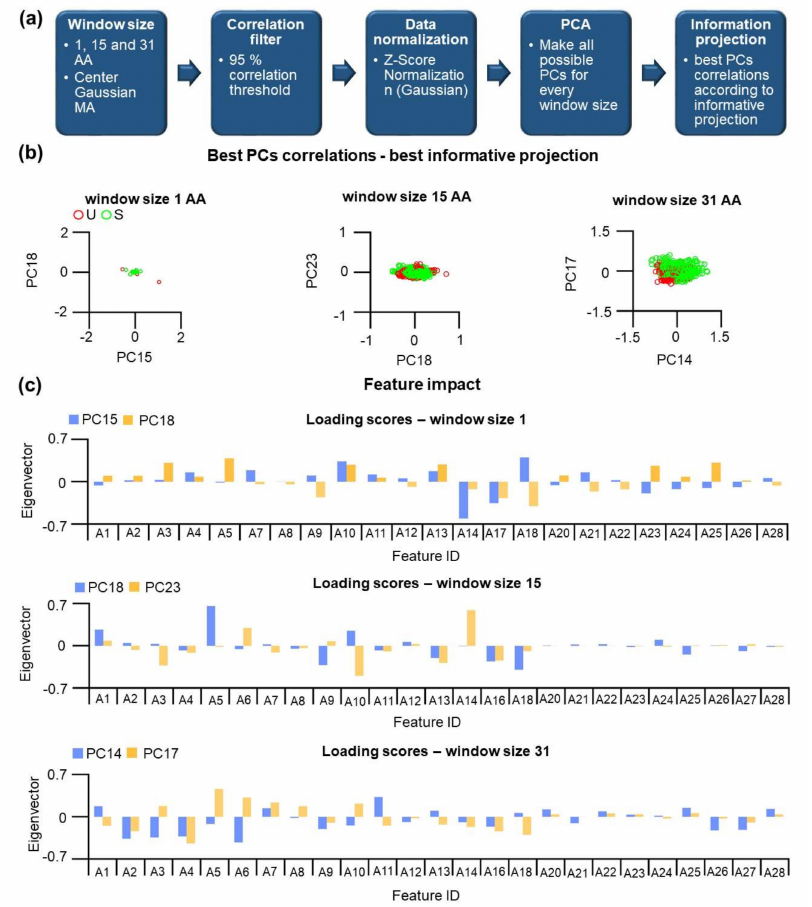
Figure 4. The application of the PCA method on data using feature values at different window sizes. ( a ) The workflow for the PCA method. ( b ) Best informative projections for classification of U/S at different window sizes. ( c ) Corresponding loading scores (from PCs in b ) for all features used for the PCA method. Different features were used due to the fact that some of them did not pass through the correlation filter (see a